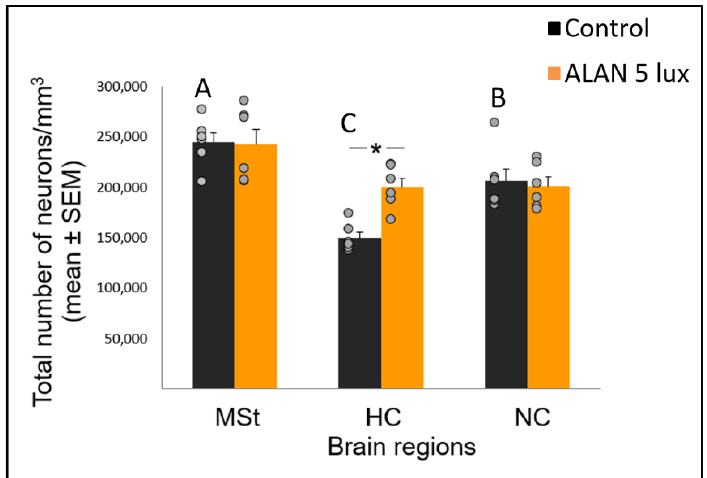
Figure 3. Total neuronal densities (number of neurons/mm 3 ; mean ± SE) in the medial striatum (MSt), hippocampus (HC) and nidopallium caudale (NC) brain regions, in birds exposed to 5 lux ALAN, and controls that remained in dark nights. Grey dots indicate the individual data points, * indicates a significant difference between groups ( p < 0.05), and different letters indicate significant differences among brain regions in the control group. ( N = 6 birds/group).